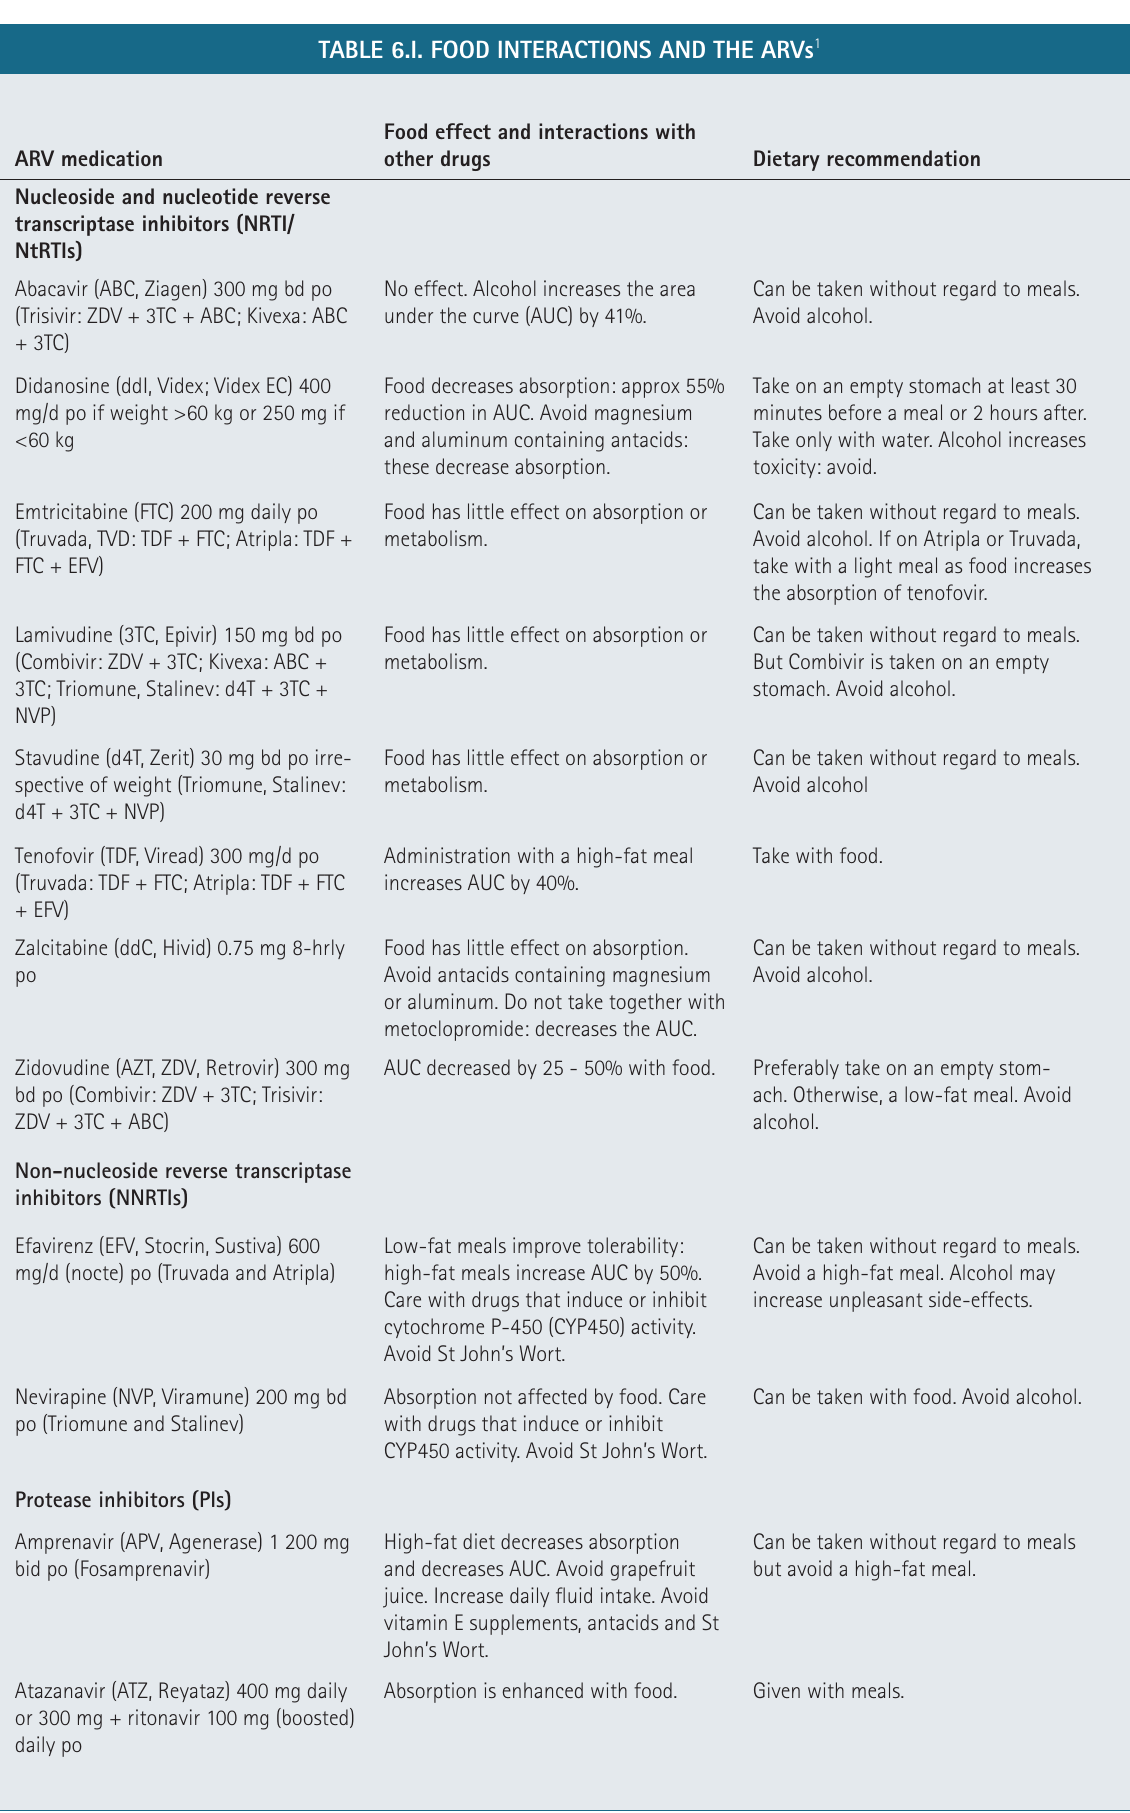
TABle 6.I. FOOD INTeRACTIONs AND THe ARVs